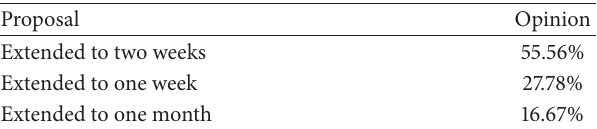
Table 2: The experts’ opinions on the time length of perichemother- apy/radiotherapy in the first round